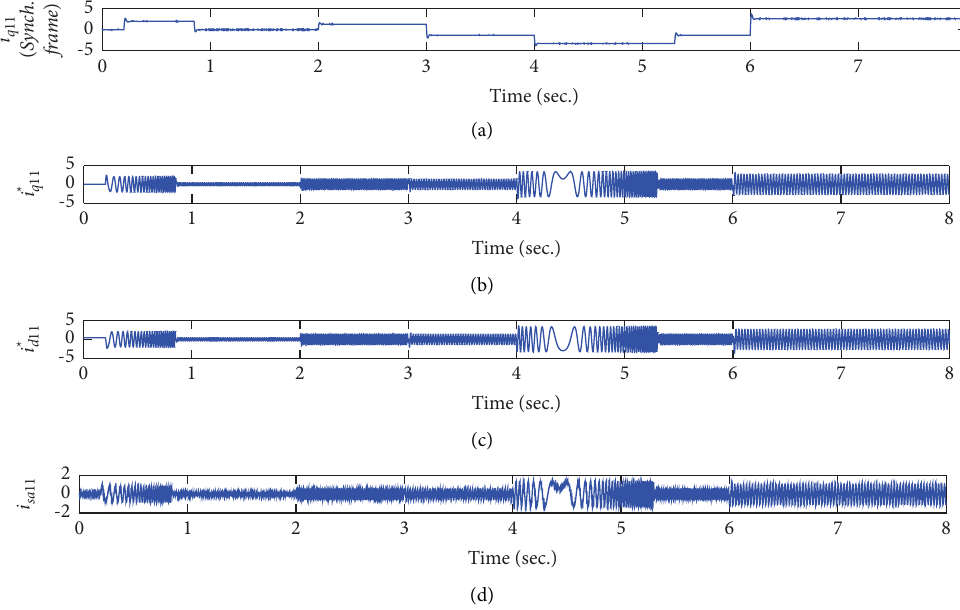
T r and (b) torque e .